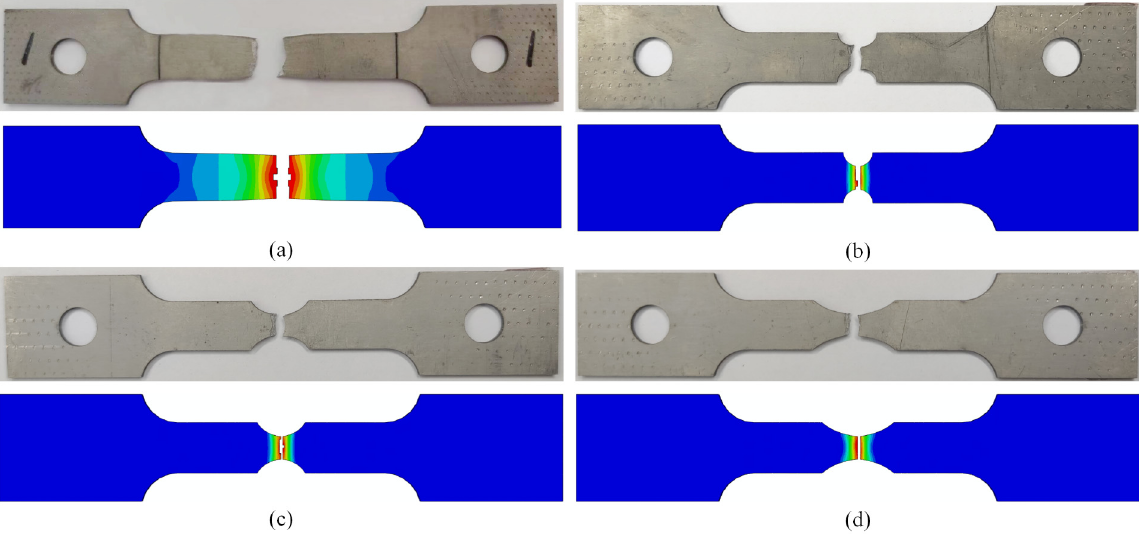
Figure 11. Comparison of tensile test and ABAQUS simulation fracture morphology: ( a ) smooth specimen; ( b ) notch 1 specimen (R = 2.5 mm); ( c ) notch 2 specimen (R = 5 mm); ( d ) notch 3 specimen (R = 10 mm).